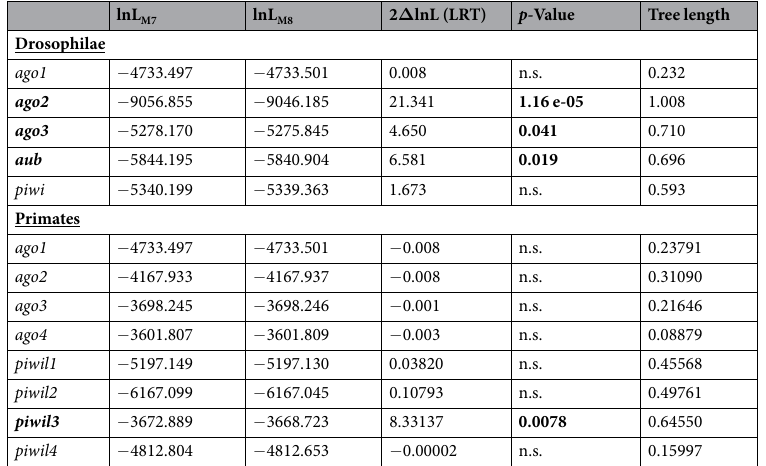
Table 2. Likelihood ratio tests (LRTs) for codon-specific evolutionary selection in argonaute sequences within Drosophila sp . and primates. The log-likelihood scores for model 7 (Neutral, LnL M7 ) and model 8 (Positive selection, LnL M8 ) were used to determine significance between these models. Therefore, the Chi-Square Distribution test (df = 2) was performed on the Likelihood ratio test (LRT) values. Sequences information of D. melanogaster , D. simulans , D. sechellia , D. yakuba and D. erecta was used to estimate codon specific evolutionary pressure within Drosophila sp. The primate species that were used for this analysis are Homo sapiens , Pan troglodytes , Pan paniscus , Gorilla gorilla , Pongo abelli , Macaca mulatta and Callithrix jacchus